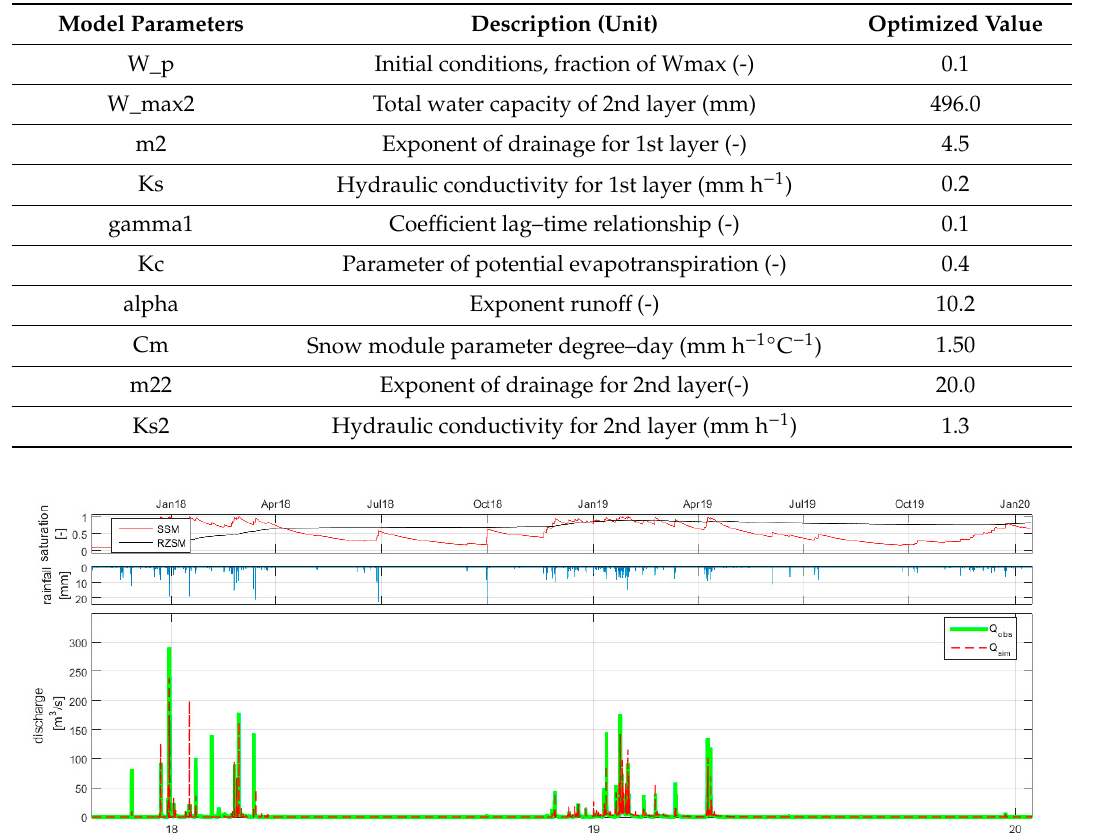
Table 1. Final optimized values of the Modello Idrologico SemiDistribuito in continuo (MISDc) model parameters.